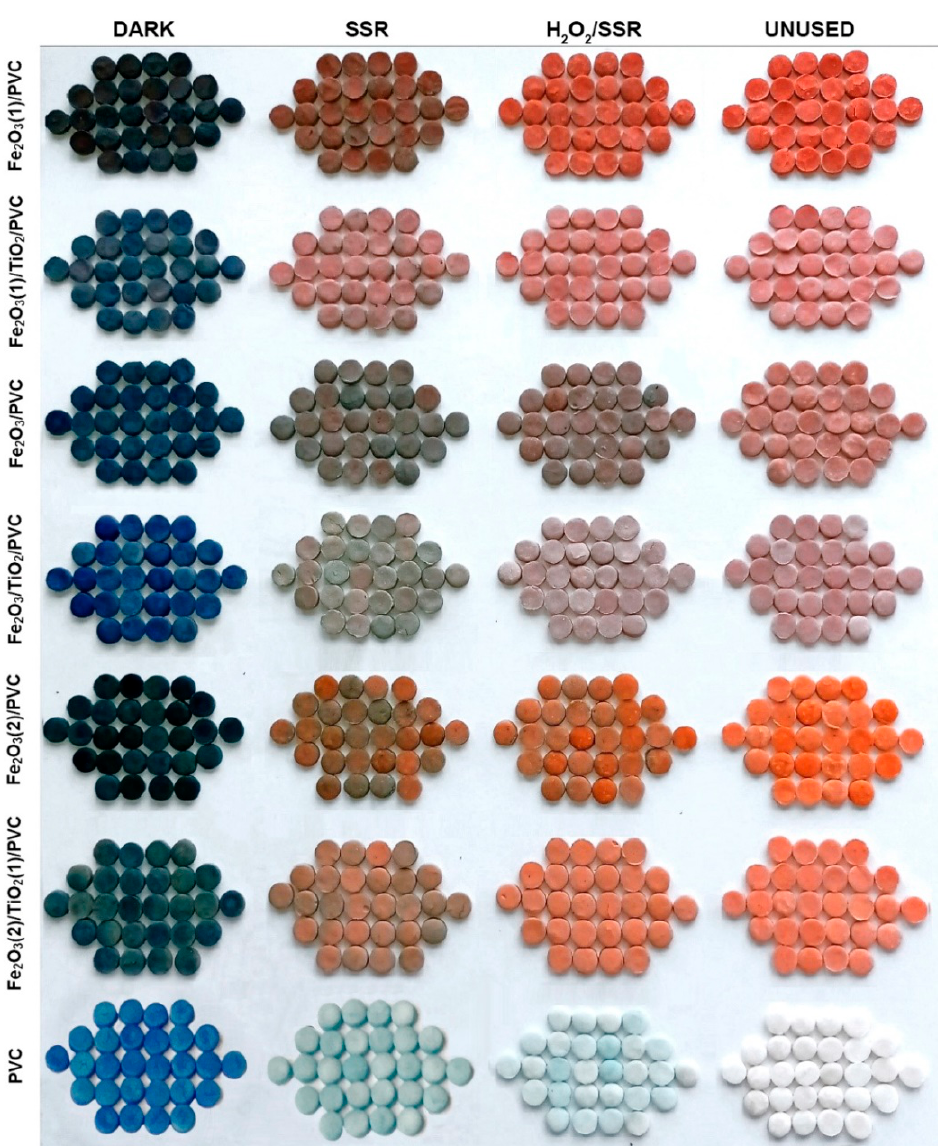
Figure 5. Photos of tablets after 180 min of the MB removal ( c 0 = 2.45 · 10 − 2 mM) at a stirring rate of 490 rpm: first column (adsorption in the dark), second column (removal in the presence of SSR), third column (rem о val in the presenc е of SSR and H 2 O 2 ) and fourth column (unused tablets).